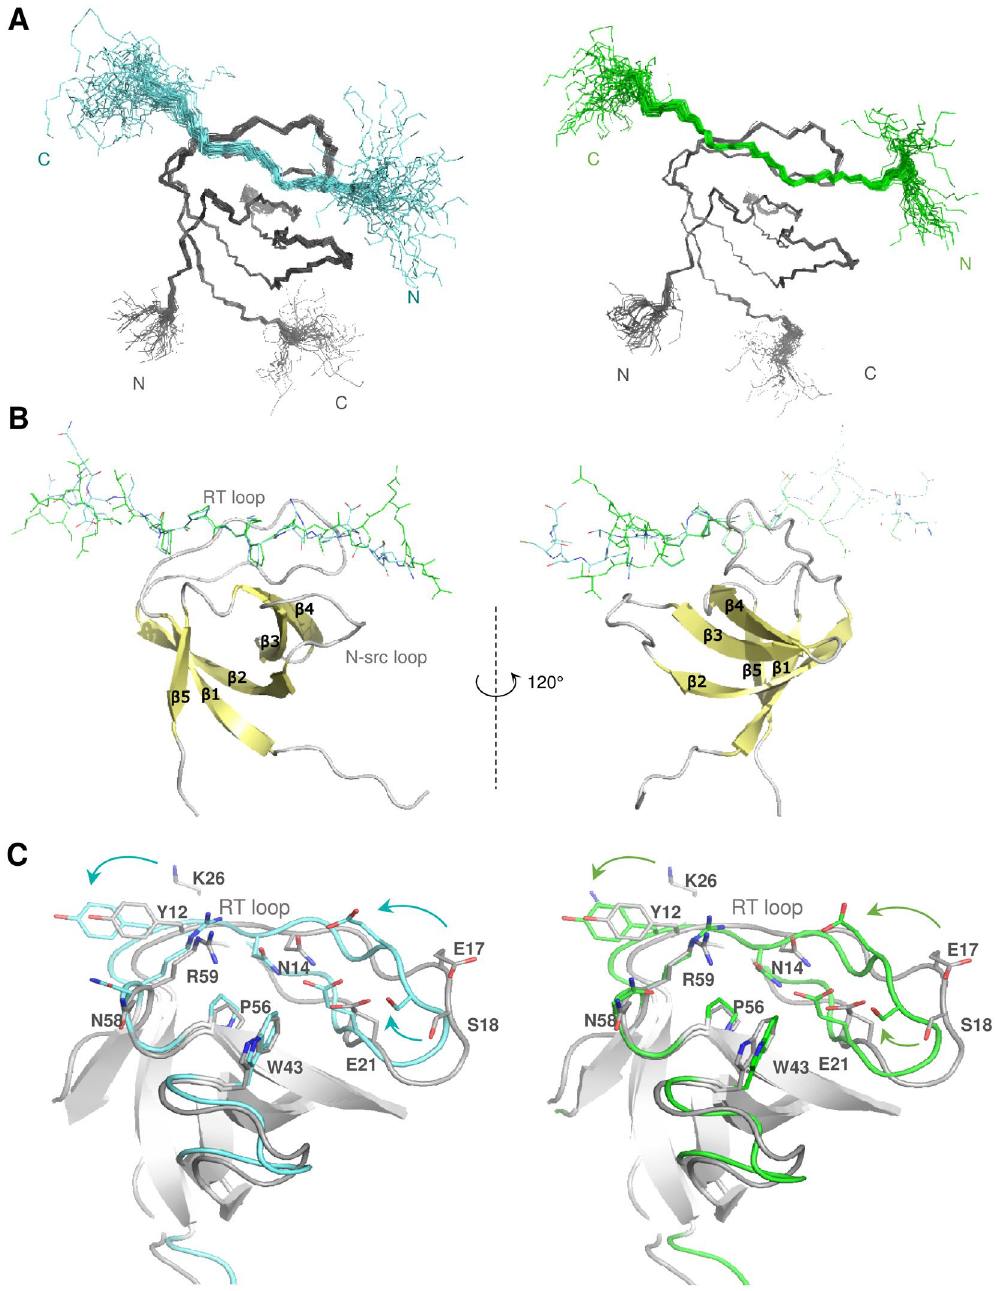
Figure 4. Solution structures of the CAS SH3 domain complexes. ( A ) Set of 40 converged structures of CAS SH3 (dark grey) with PTP-PEST- (cyan, left) and Vinculin-derived peptide (green, right). ( B ) A cartoon representation of the complexes. ( C ) Superimposition of the free CAS SH3 domain (grey) and PTP-PEST- (cyan) and Vinculin-bound (orange) CAS SH3 domains. The β -sheets are in